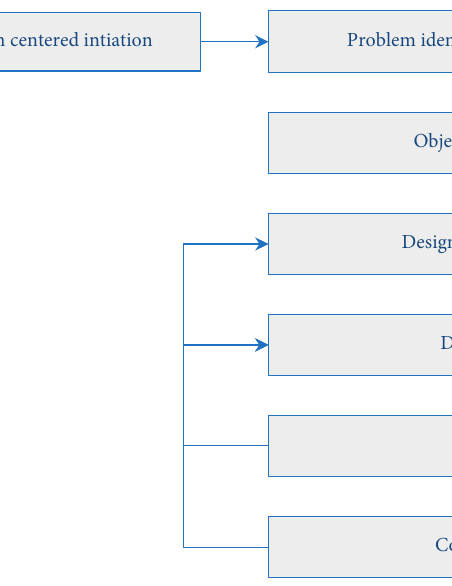
Figure 1: DSRM processes’